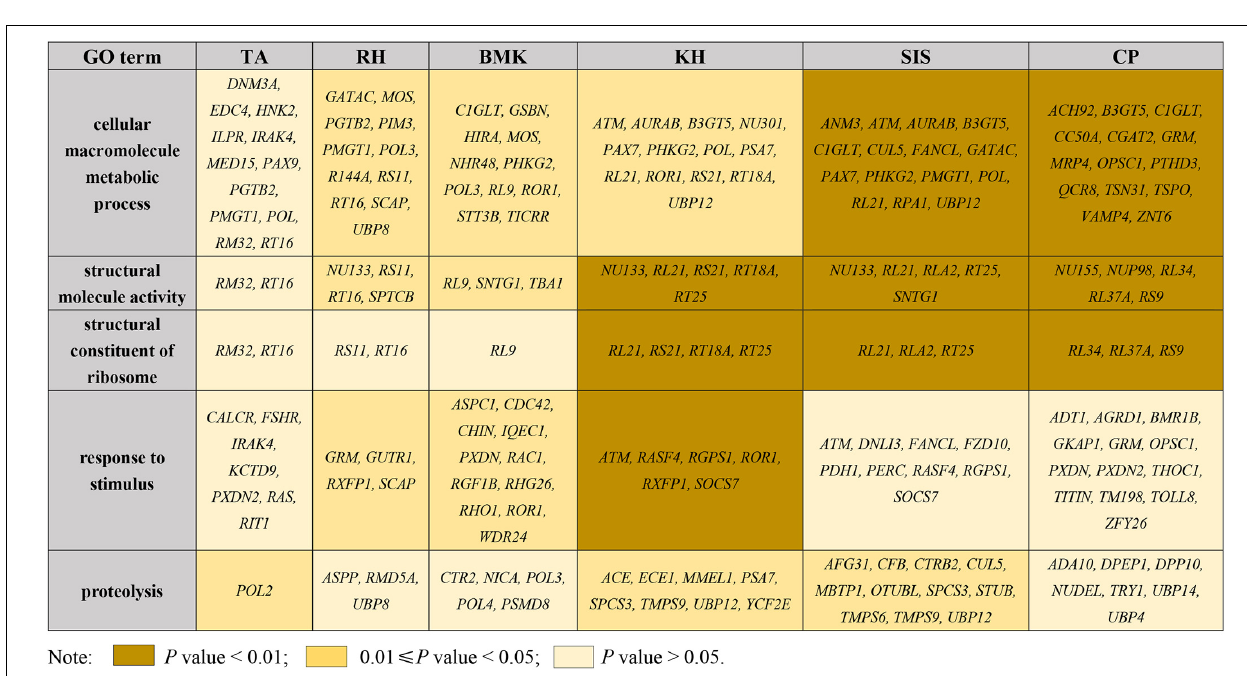
FIGURE 3 | Selective sweep and Gene Ontology (GO) enrichment analysis of the BMK samples. (A) Distribution of θ π ratios ( θ π reference population/ θ π selective breed) and F st values calculated in 50 kb window with a 10 kb step. Windows with the 5% largest or smallest of θ π ratio, and the top 2% largest F st were highlighted as regions under selection. (B) Enriched GO terms of genes under selection.